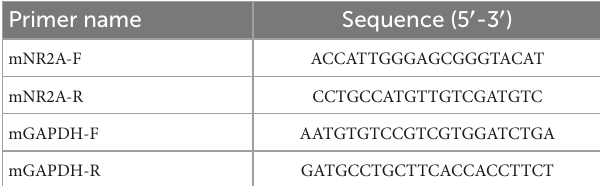
TABLE 1 Primers for real-time